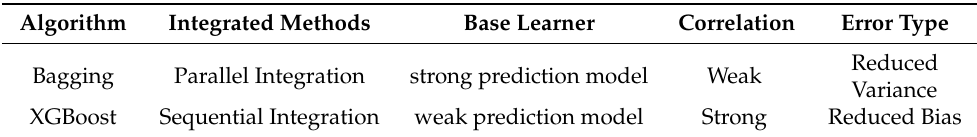
Table 1. Comparison of sequential -parallel ensemble learning.